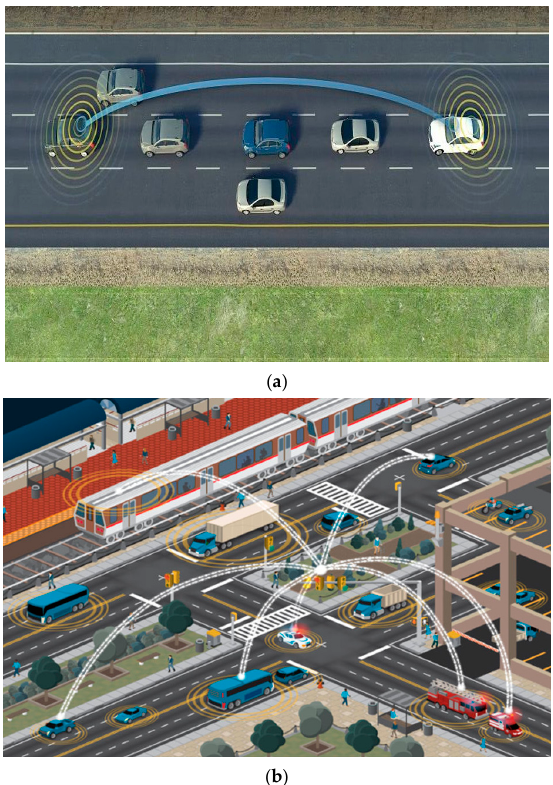
Figure 2. Vehicle communication through ( a ) AV2V communication, and ( b ) AV2X